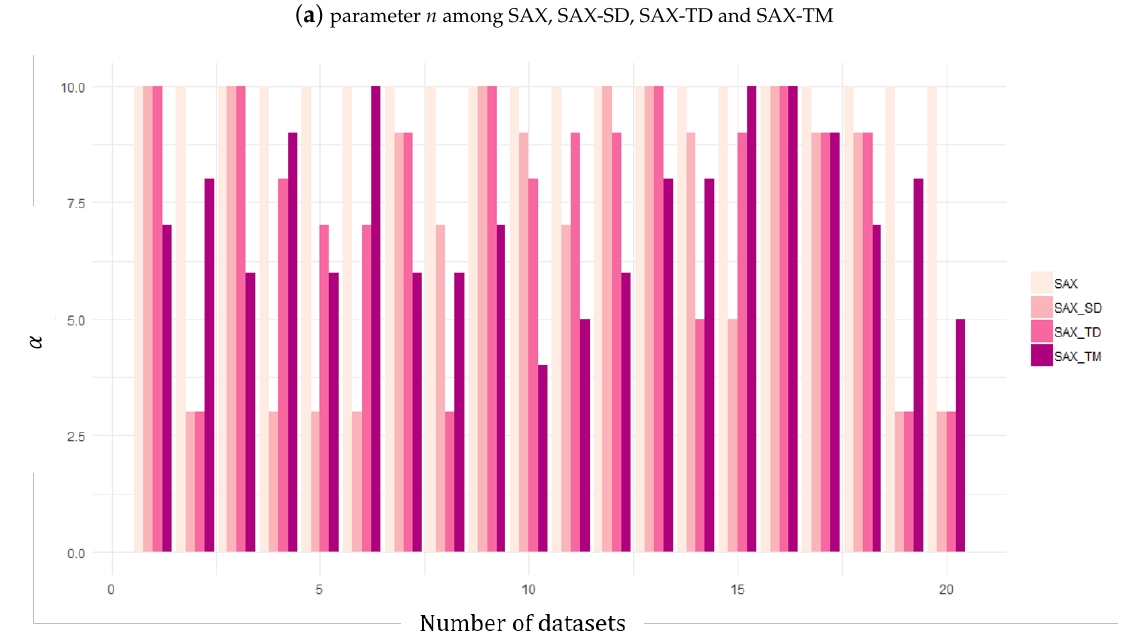
Figure 3. Parameters among SAX, SAX-SD, SAX-TD, and